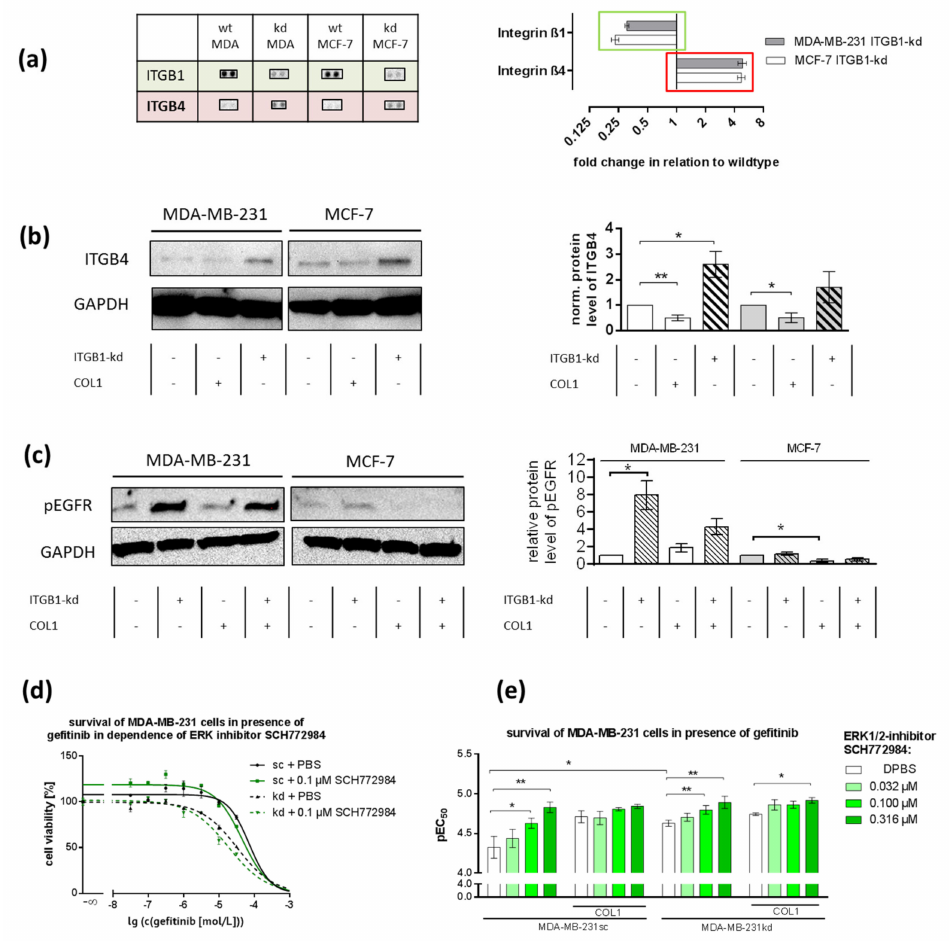
Figure 7. The role of EGFR in MCF-7 and MDA-MB-231 cells in COL1 induced cell activation a ff ected by integrin β 1 -knockdown (ITGB1-kd). ( a ) Data of a surface receptor proteome profiler array indicate that the knockdown of ITGB1 (green) in MDA-MB 231 and MCF-7 cells was antagonized by the upregulation of integrin β 4 (ITGB4, red) compared to wildtype (wt). ( b ) Western blot of ITGB4 in MCF-7 and MDA-MB-231 scrambled (sc) cells in dependence of collagen type 1 (COL1) or ITGB1-status ( n = 3 biological samples). GAPDH was used as loading control. Data indicate that ITGB1-kd is associated with the upregulation of ITGB4. ITGB4 can form an active crosstalk to activate ( c ) pEGFR in MDA-MB-231kd, but only slightly in MCF-7kd cells ( n = 3 biological samples). ( d , e ) Blocking of pEGFR by gefitinib was highly synergistic with ERK1 / 2-inhibition in MDA-MB-231 cells indicating a key role of EGFR in COL1-induced activation of MDA-MB-231 cells ( n = at least 3 biological samples). Statistical analysis was performed via unpaired t -test (* p < 0.05; ** p <